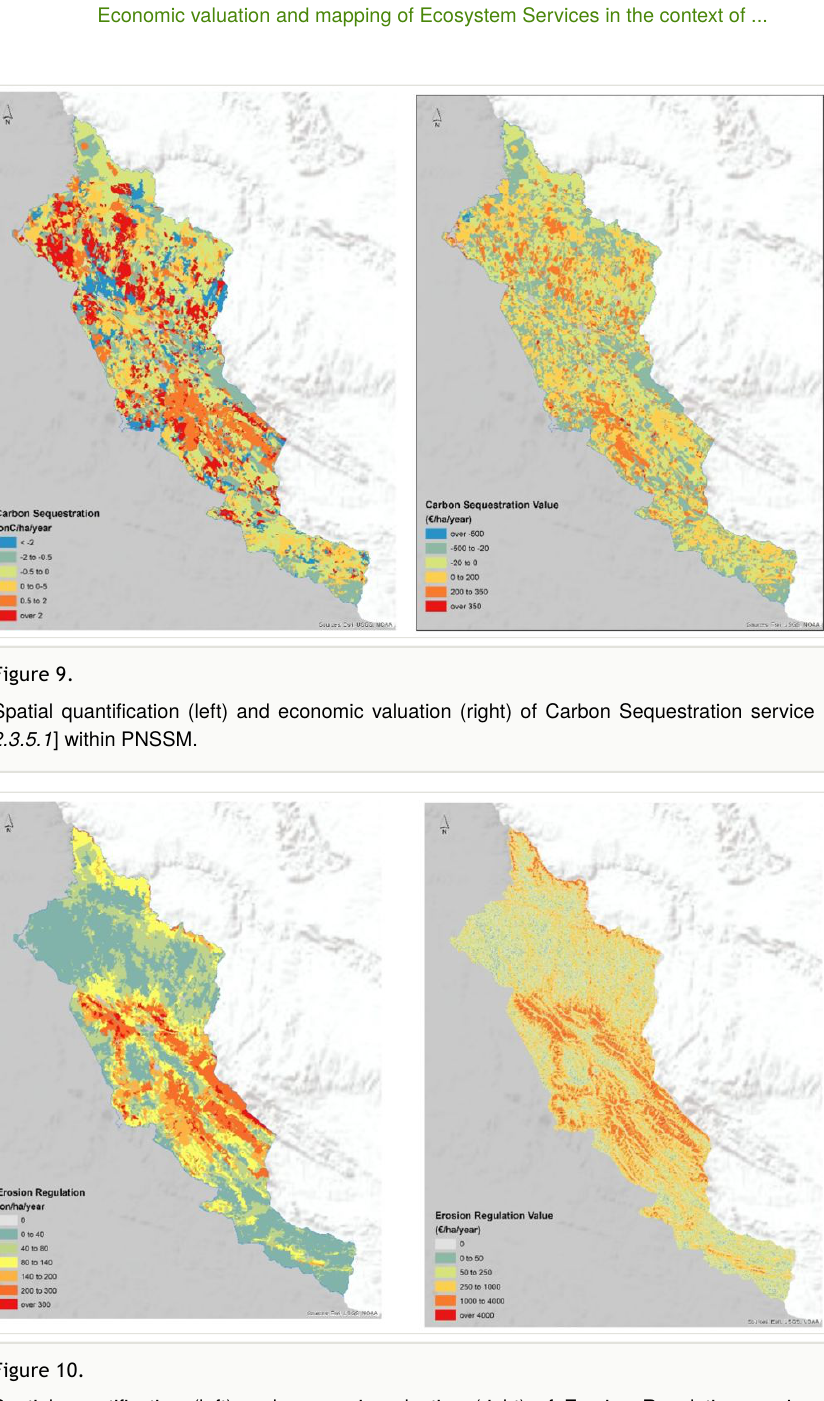
Figure 10. Spatial quanti fi cation (left) and economic valuation (right) of Erosion Regulation service [ 2.2.1.1 ] within